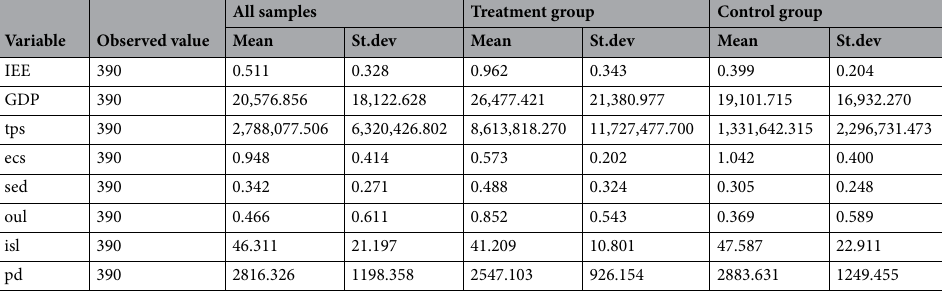
Table 3. Descriptive statistics of variables.